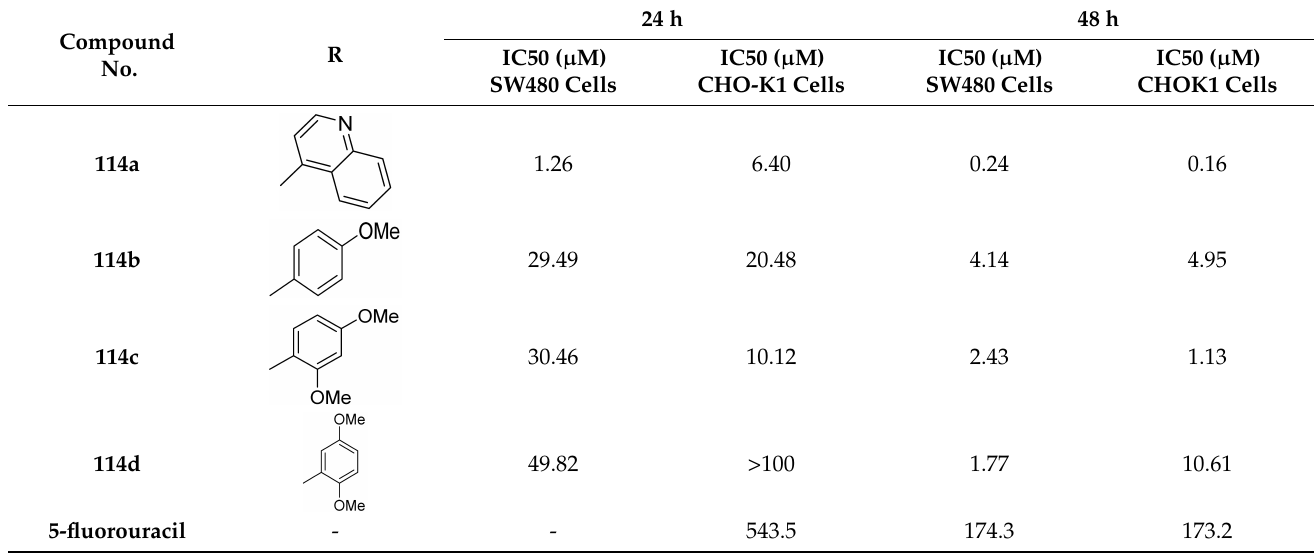
Table 96. In vitro cytotoxic activities of chalcone based melatonin hybrid